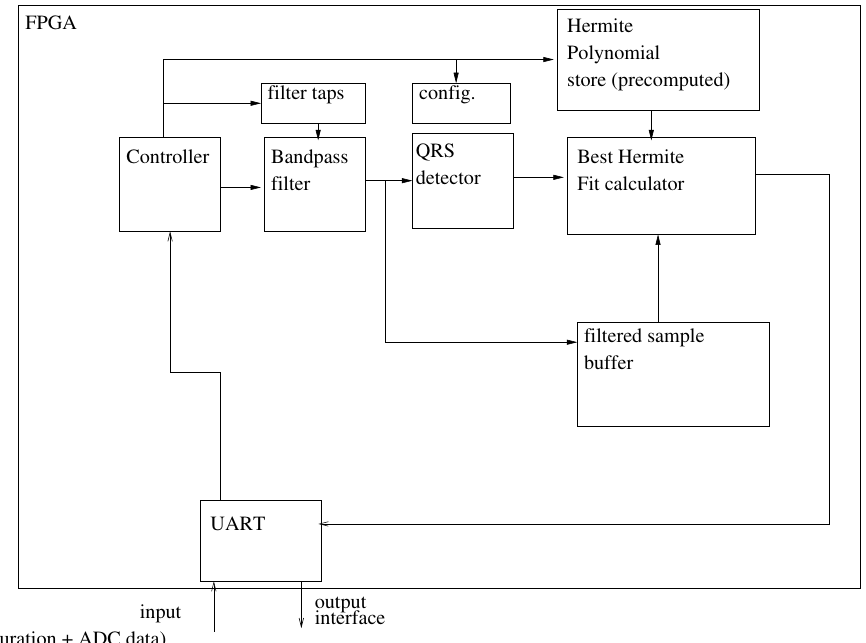
Figure 7. System